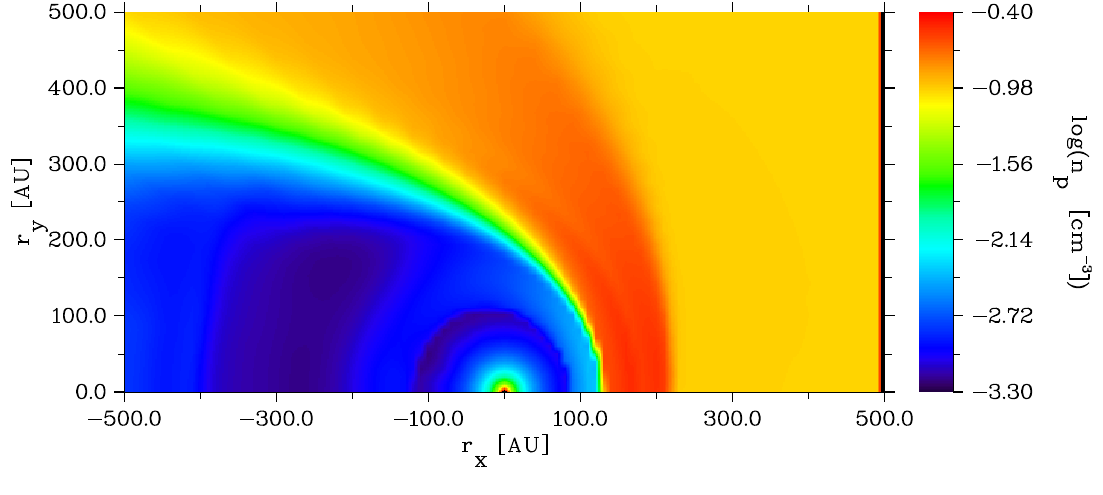
Fig. 2. Same as in Fig. 1 in a logarithmic scale, which enhances the effects in heliotail region.